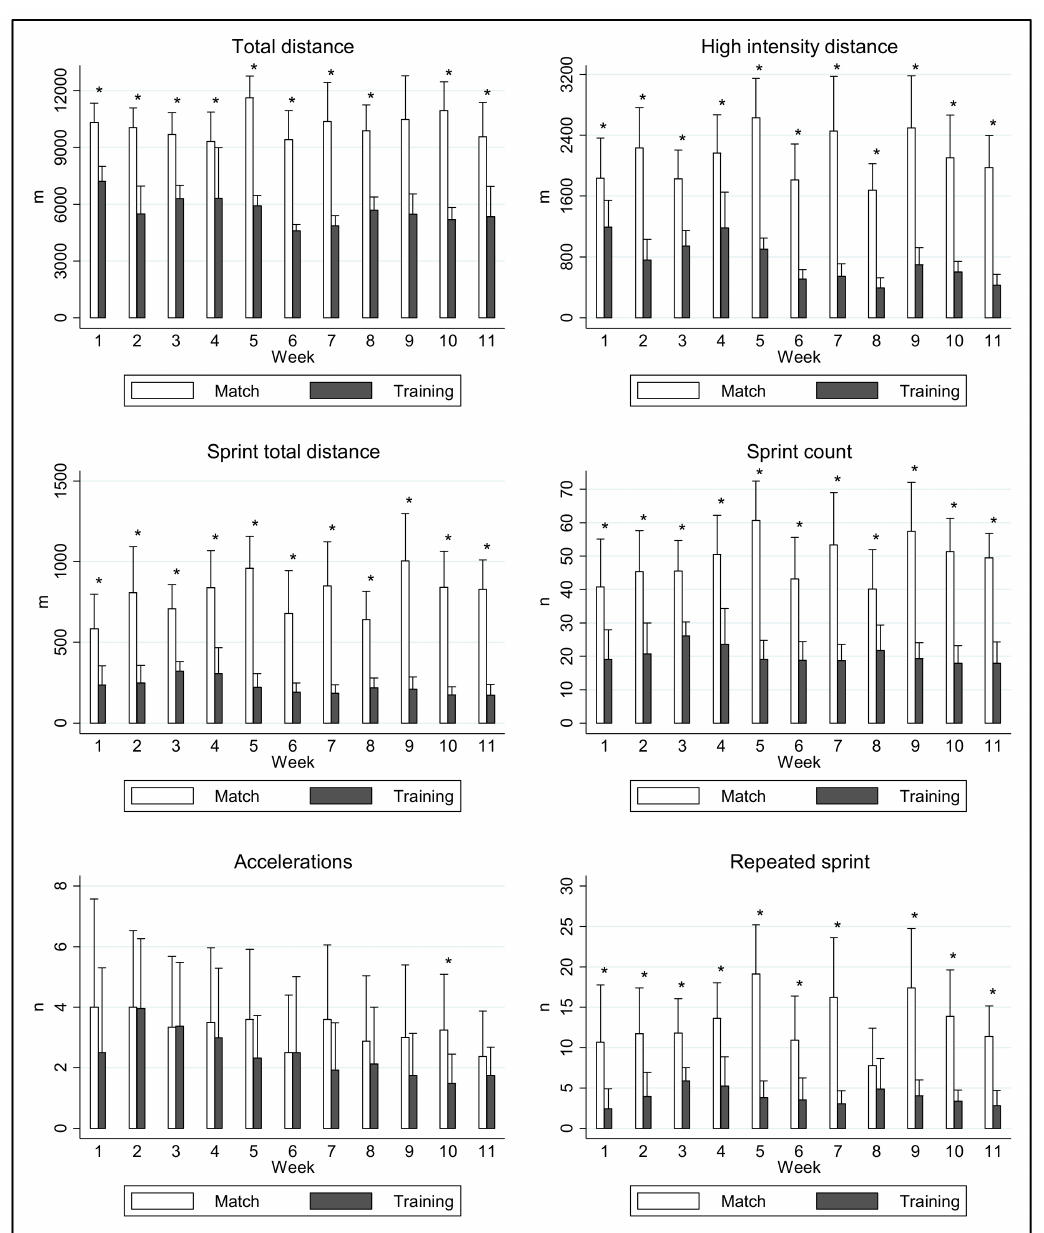
Figure 1. Physical demands of training and match play in young elite soccer players. * Differences between training sessions and matches ( p < 0.05). Bars display mean ± standard